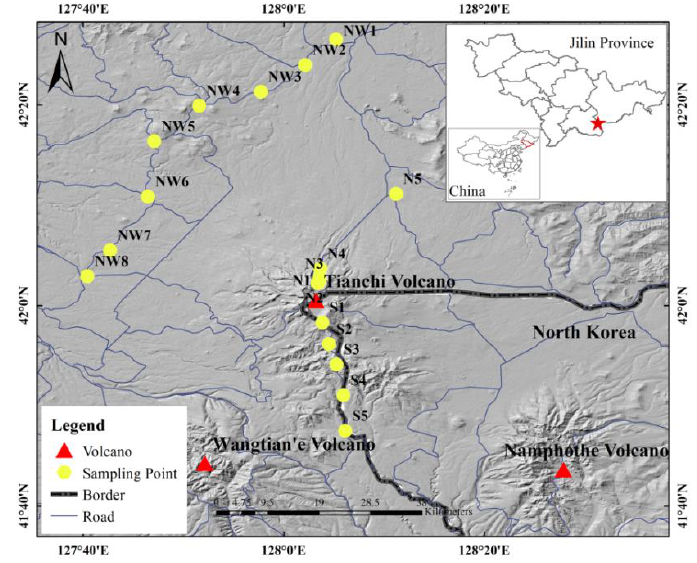
Figure 2. Distribution of sampling sites in Changbai Mountain.